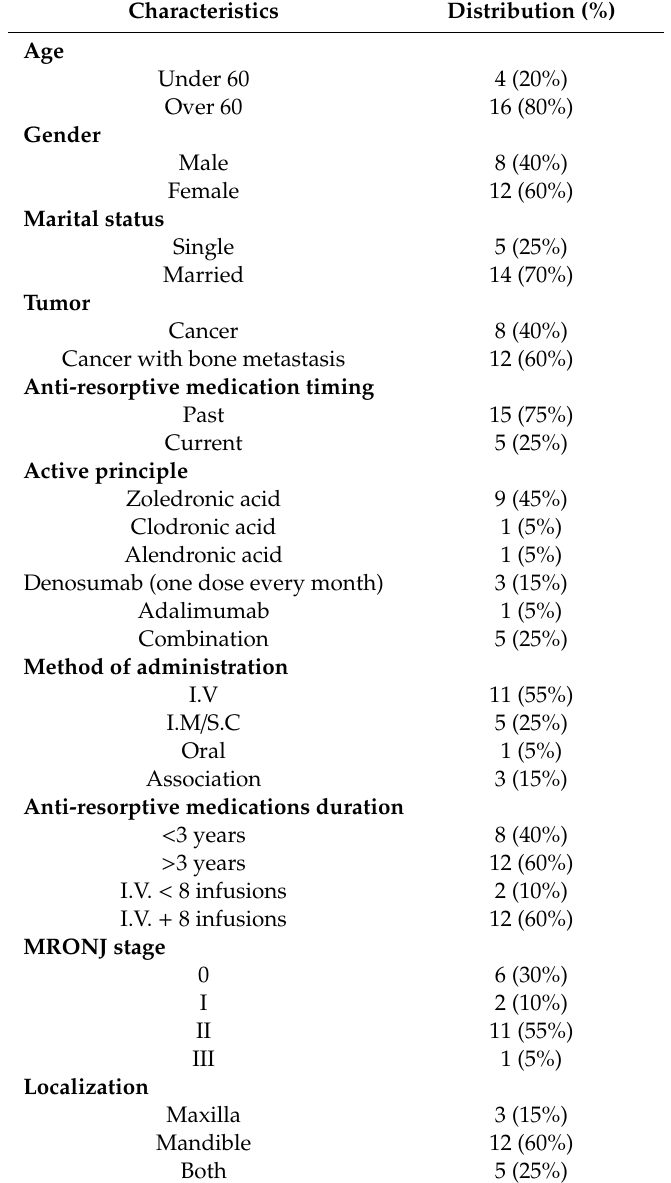
Table 1. Study sample